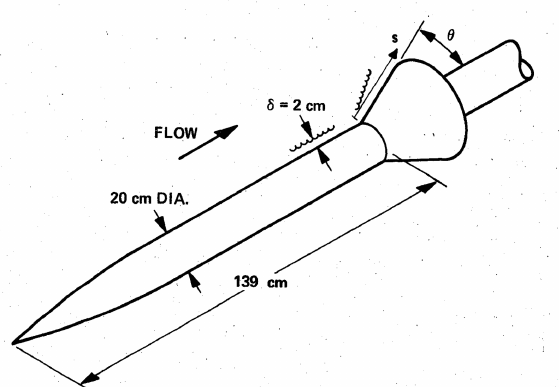
Figure 10. Diagram of experimental [53] configuration for axisymmetric shock-wave boundary-layer